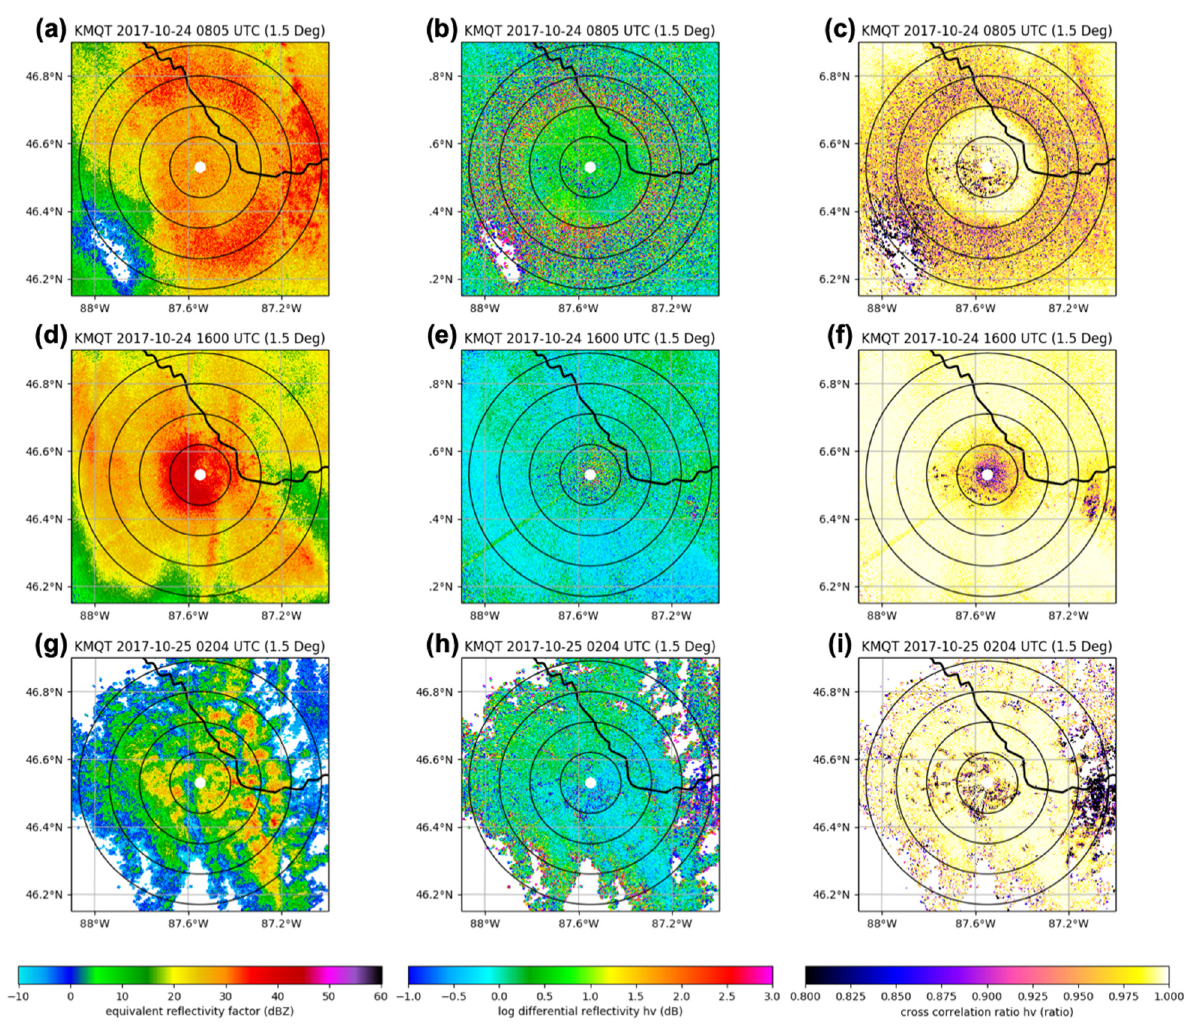
Figure 11. WSR-88D values of reflectivity, differential reflectivity (Z DR ), and cross correlation ratio ( ρ HV ) for 24 October 2017 0805 UTC ( a – c ) and 1600 UTC ( d – f ), and 25 October 2017 0204 UTC ( g – i ).